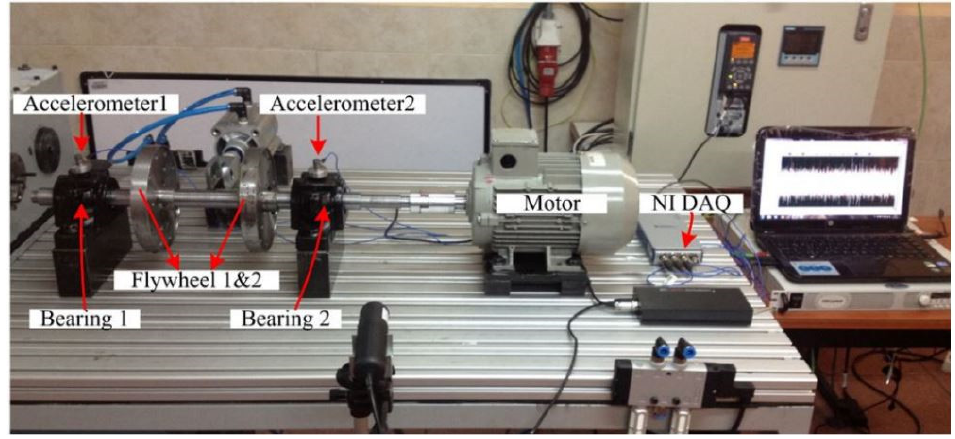
Figure 3. Experimental setup for the GIDTEC bearing dataset collection [50].